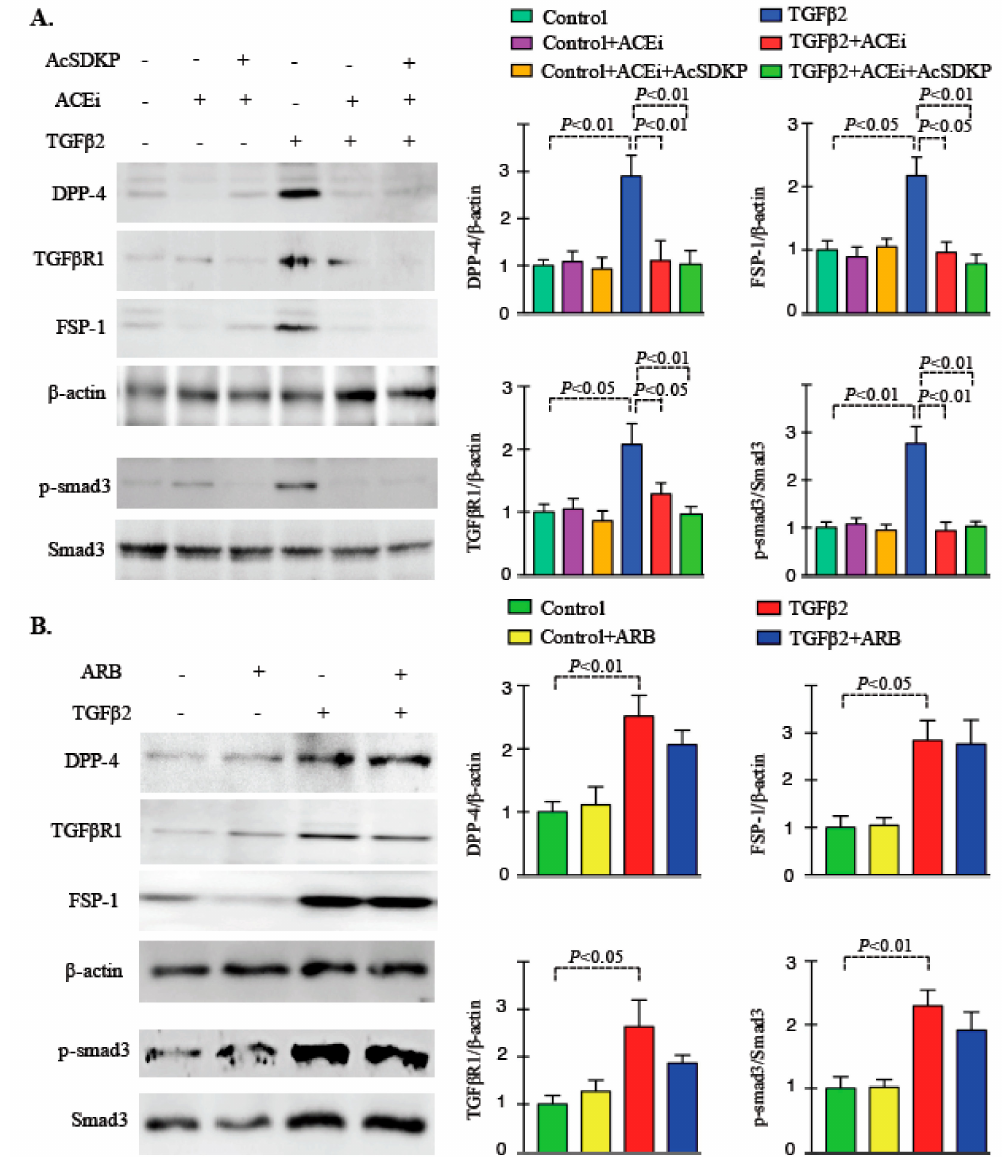
Figure 3. Inhibition of ACE inhibit DPP-4 level and TGF β signaling in endothelial cells. ( A ) Western blot analysis in the ACEi and ACEi + AcSDKP treated HMVECs in presence and absence of TGF β 2. Quantification of DPP-4, TGF β R1, FSP-1, p-smad3 and smad3 respectively by densitometry. Representative blots are shown. The data was normalized by β -actin. N = 3 were analyzed in each group. ( B ) Western blot analysis in the ARB treated HMVECs in presence and absence of TGF β 2.